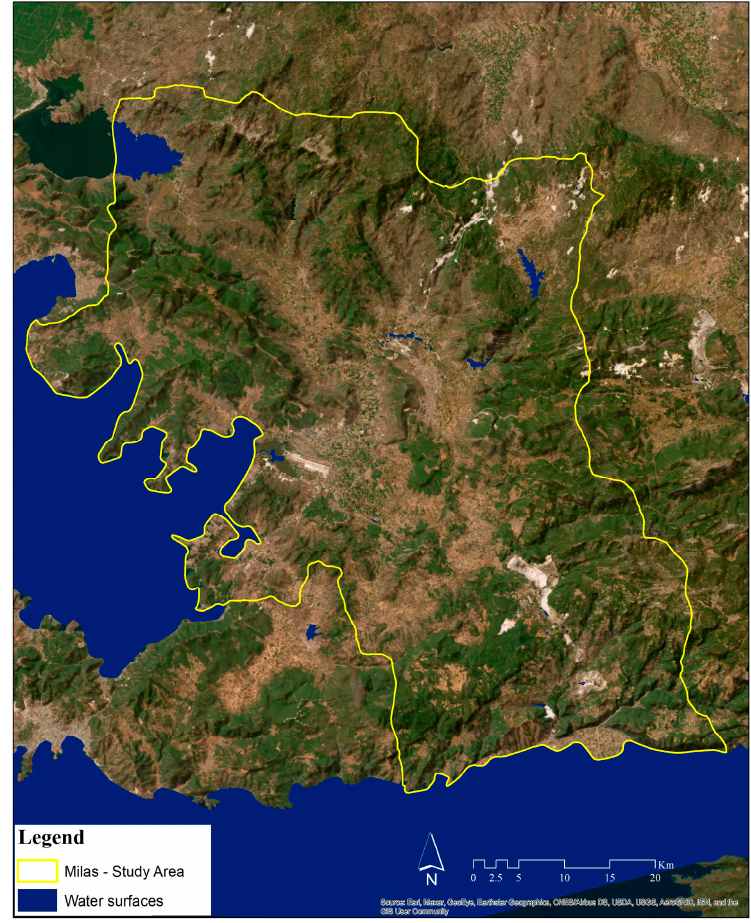
Figure 16. Natural water sources.